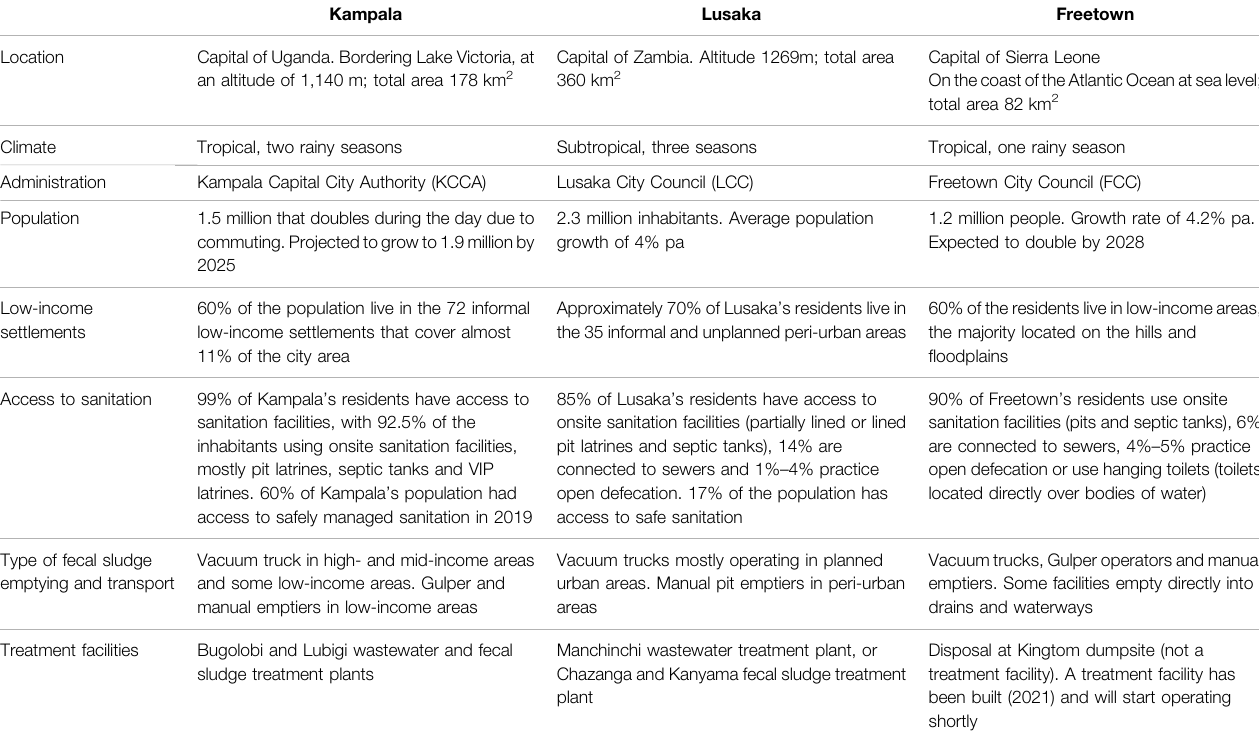
TABLE 2 | Cities ’ wider context (source: document analysis and